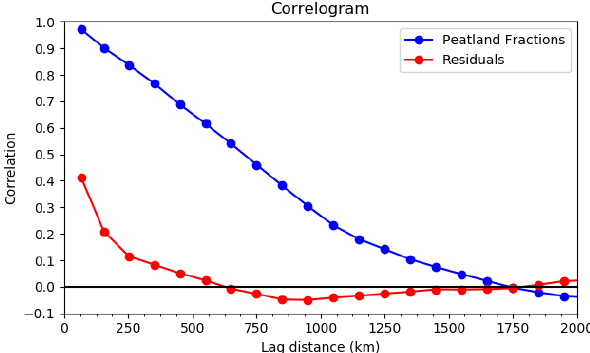
Figure A1. Correlogram showing the spatial correlation be- tween model residuals as a function of distance computed using Moran’s I